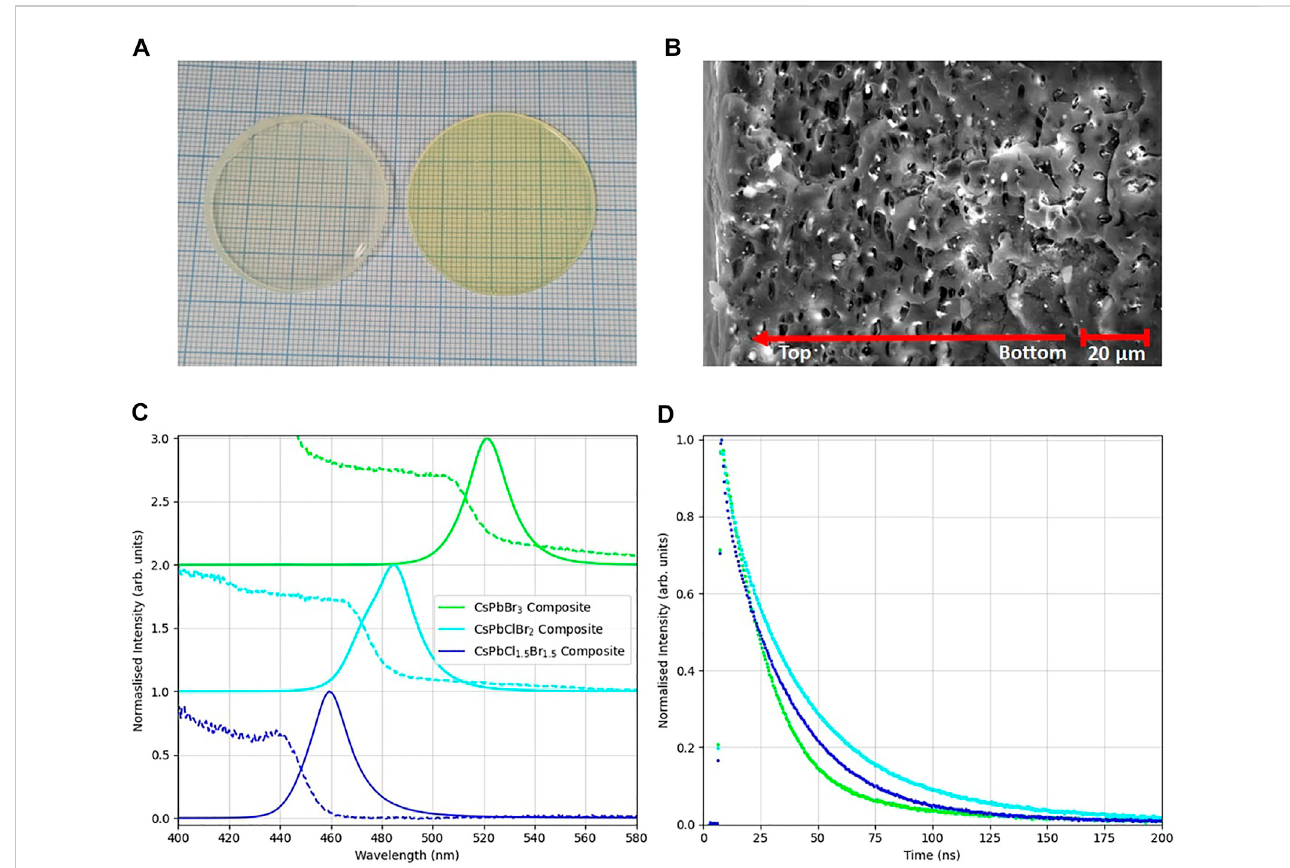
measured with EDX.